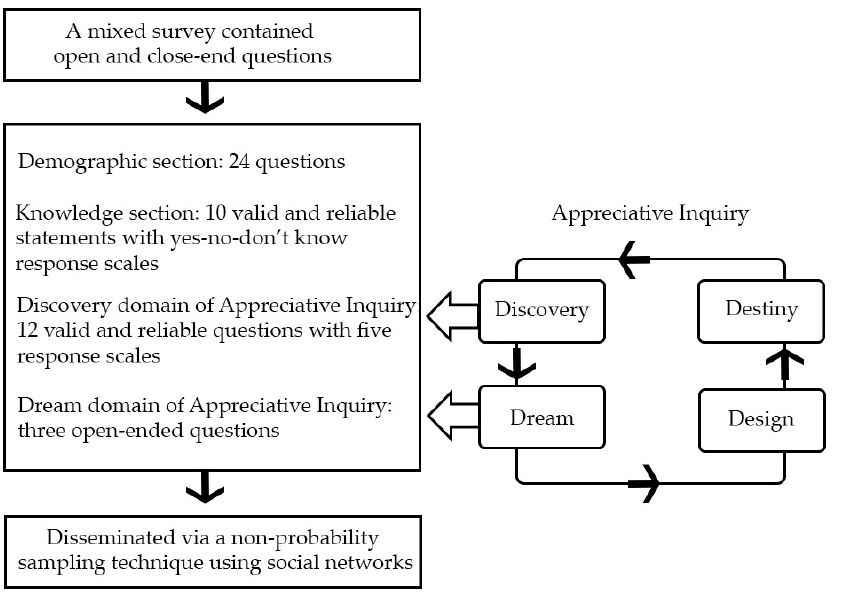
Figure 3. Mixed methods survey